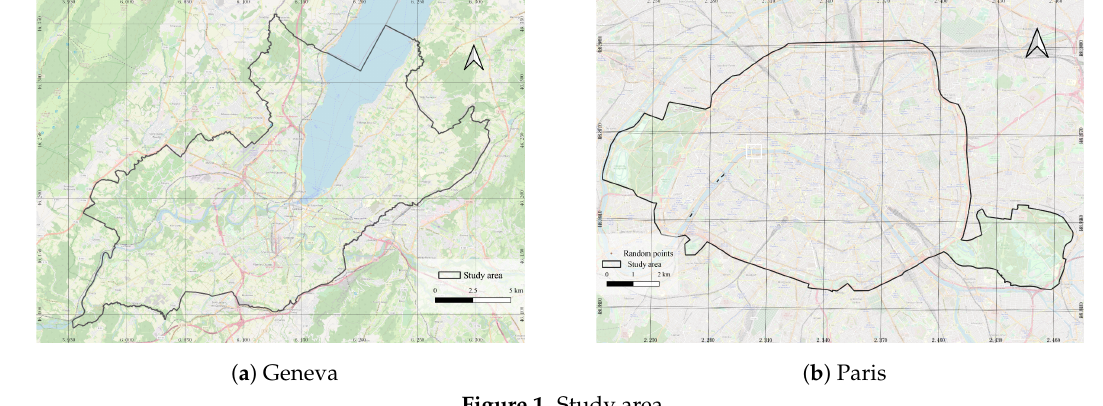
Figure 1. Study area.